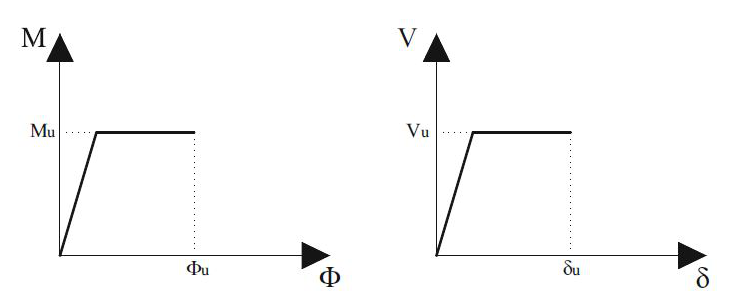
Figure 23. Plastic hinge law for masonry